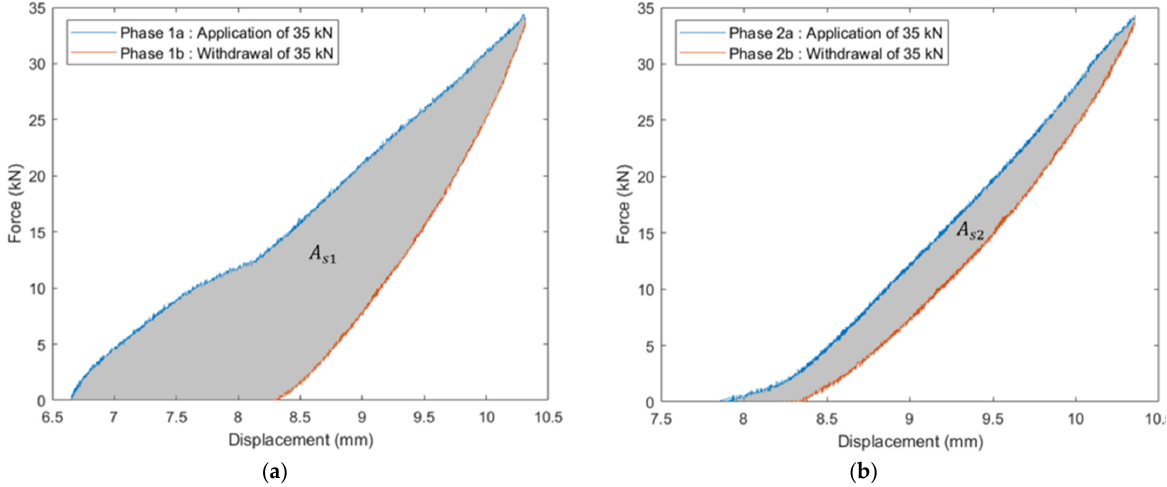
Figure 10. ( a ) Shear loading phase 1, dissipated energy area shown in grey (As1), ( b ) shear loading phase 2, dissipated area shown in grey (As2).